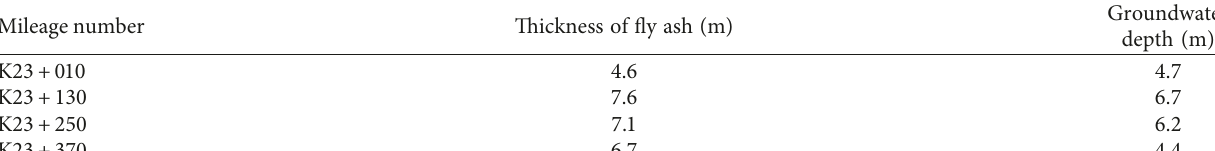
Table 3: Thickness of fly ash and groundwater depth.